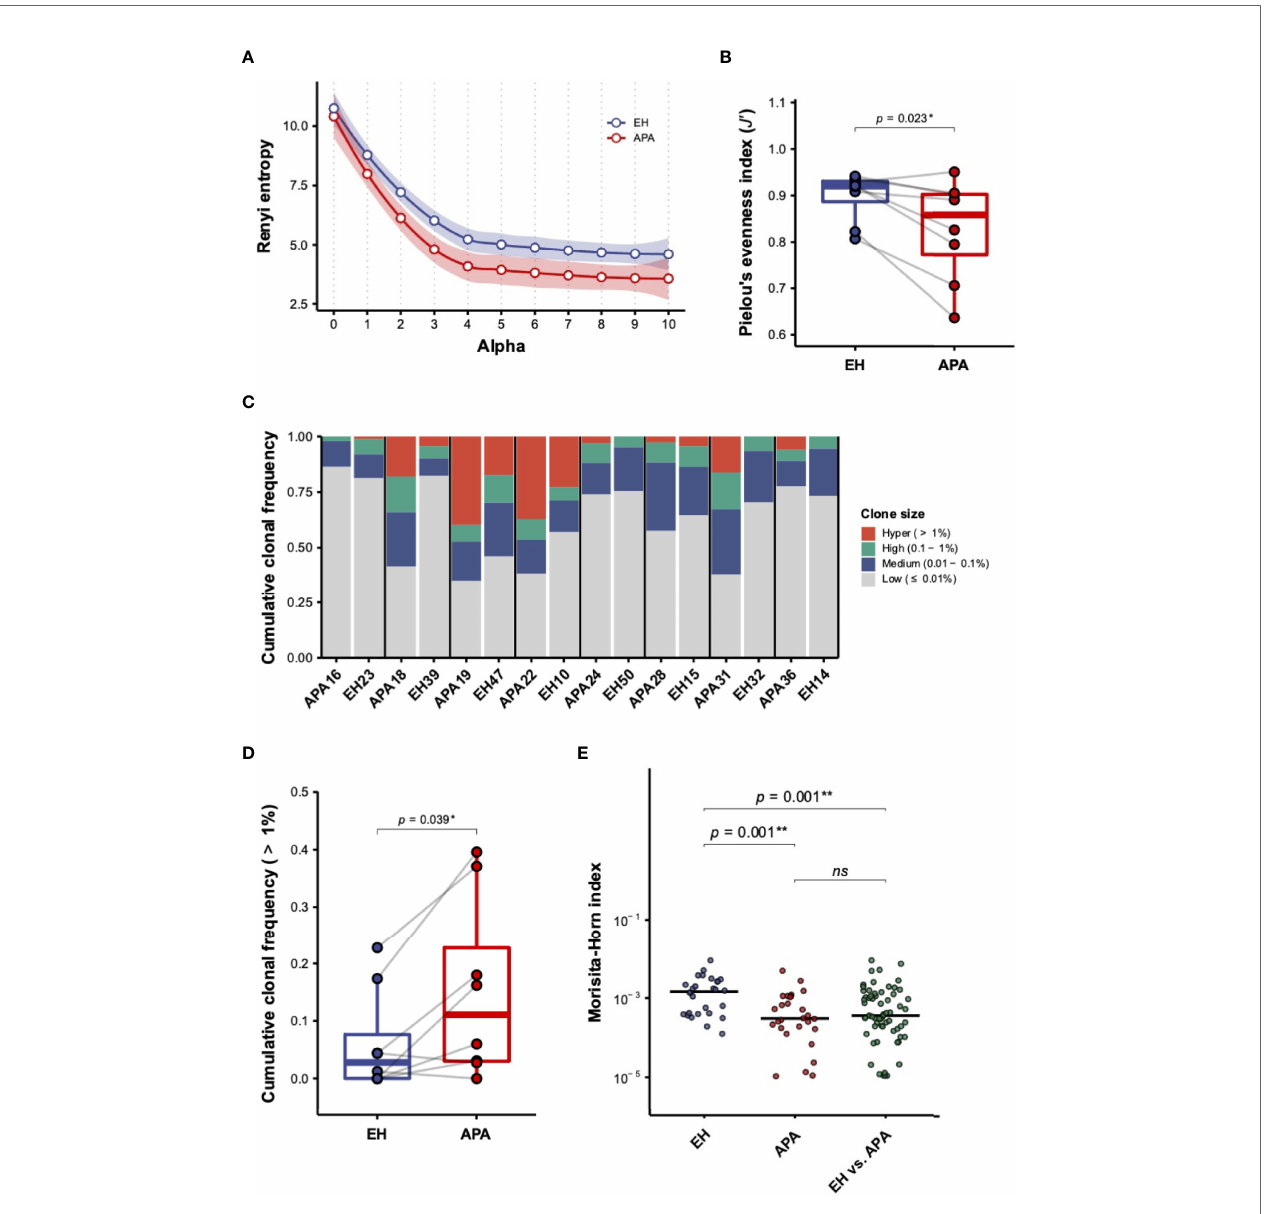
FIGURE 1 | The characterization of TCR b repertoire in aldosterone-producing adenoma (APA) and essential hypertension (EH) patients. (A) The diversity pro fi le based on the Re ́ nyi entropy ( a H ) was illustrated. Each dot represented the mean of Re ́ nyi entropies of EH (blue dot) or APA (red dot) patients for a speci fi c order of a (alpha) value. The smooth line and shading region indicated the estimated local polynomial regression fi tting curve and 95% con fi dence intervals (CIs), respectively, of Re ́ nyi entropies in the EH (blue color) and APA (red color) groups with a value ranging from 0 (clonal richness) to 10 (clonal dominance). The local regression was performed using the locally estimated scatterplot smoothing (LOESS) method. (B) The difference in repertoire diversity was evaluated by comparing Pielou ’ s evenness indices between APA and age-matched EH patients. The solid gray line denoted age-matched pairs. A two-sided p -value was shown from the Wilcoxon signed-rank test. (C) Cumulative frequencies of TCR b clonotypes of hyper- (>1%), high- (0.1%~1%), medium- (0.01%~0.1%), and low-abundant ( ≤ 0.01%) clone sizes were illustrated for each patient. Stacked bars with cumulation of clonal frequencies for different clone sizes of each pair of APA patients and age-matched EH individuals were displayed. (D) The cumulative frequency of hyper-abundant (>1%) TCR b clonotypes was compared between APA and age-matched EH patients. The solid gray line denoted age-matched pairs. A two- sided p -value was shown from the Wilcoxon signed-rank test. (E) The Morisita – Horn (MH) index was calculated for intragroup (any two of APA or EH patients) and intergroup (any one of EH vs. one of the APA patients) repertoire similarity. The comparison between intragroup and intergroup MH indices was depicted. The horizontal line represented the median. The FDR-adjusted two-sided p -values were shown from the Wilcoxon rank-sum test. The results of the comparison with corrected p -value >0.05 were considered to be not statistically signi fi cant and denoted by “ ns ” (not signi fi cant). p -values < 0.05 or < 0.01 were considered to be statistically signi fi cant and marked with ‘ * ’ or ‘ ** ’ ,